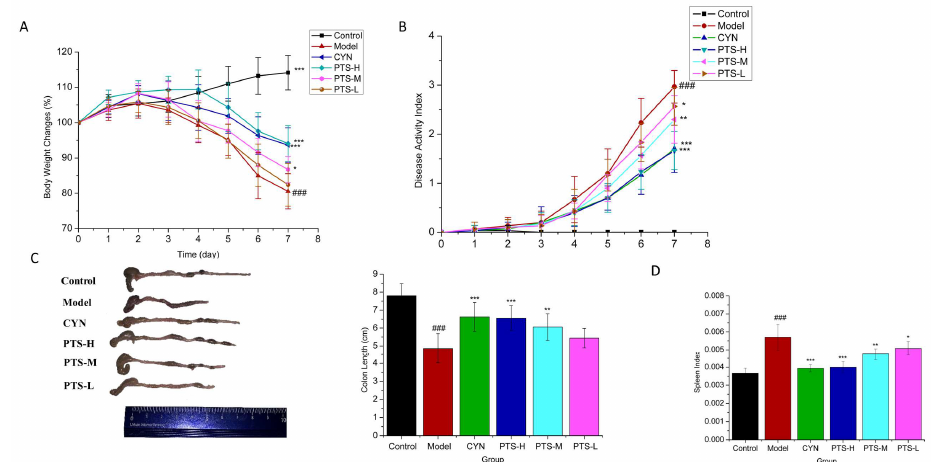
Figure 2. Effects of PTS on clinical symptoms of mice with DSS-induced ulcerative colitis: ( A ) body weight change of each group (n = 10); ( B ) disease activity index (DAI) (n = 10); ( C ) colon length (n = 10); ( D ) spleen index (n = 10). Data are expressed as the means ± SDs. ### p < 0.001 vs. control. * p < 0.05, ** p < 0.01, and *** p < 0.001 vs. model group.